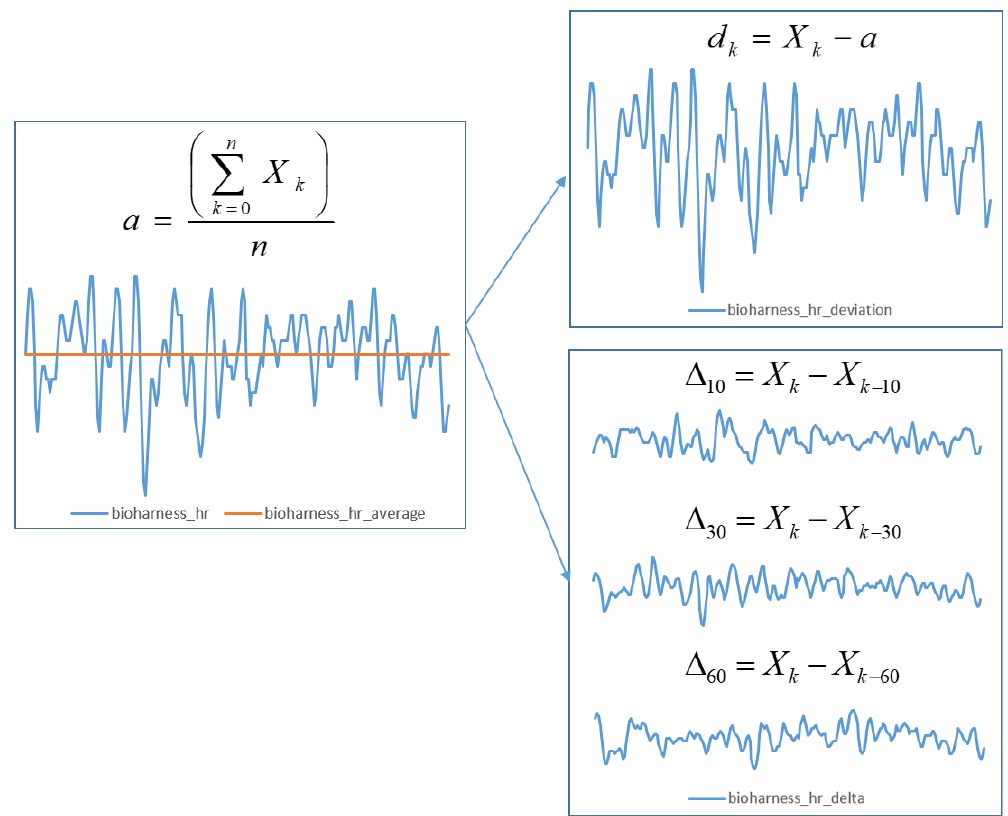
Figure 6. Illustration of feature extraction process, including the derivation of additional features based on raw physiological sensoric data. After calculating the session average for each measurement, we derived a value of deviation from the average as well as delta values (change of each feature over three different time windows). The X-axis represents the sample number (time) and the Y-axis represents the value of the feature.